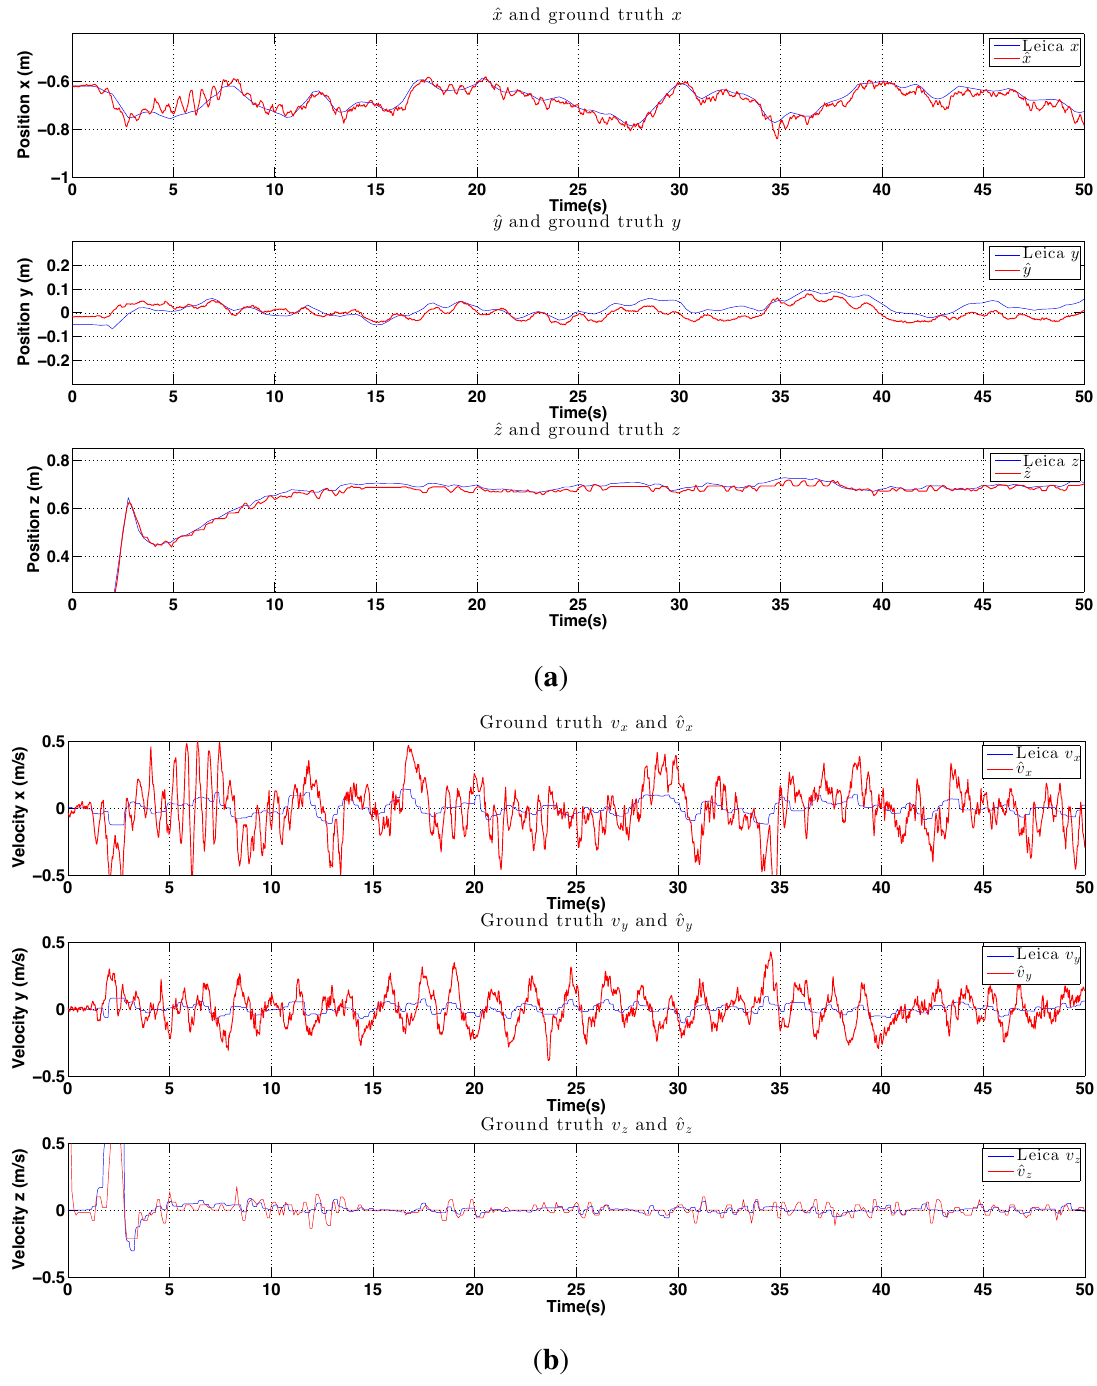
Figure 28. Experimental results for outdoor (night) PBVS-based hovering: estimator performance. Estimated angles are omitted and all states are shown at the same scale. The performance evaluation summary of these plots is presented in Figure 22. ( a ) Position estimation (red) with ground truth (blue). Note that z-axis is inverted for visualization; ( b ) Velocity estimation (red) with ground truth (blue), W ˆ˙ x , W ˆ˙ y and W ˆ˙ z